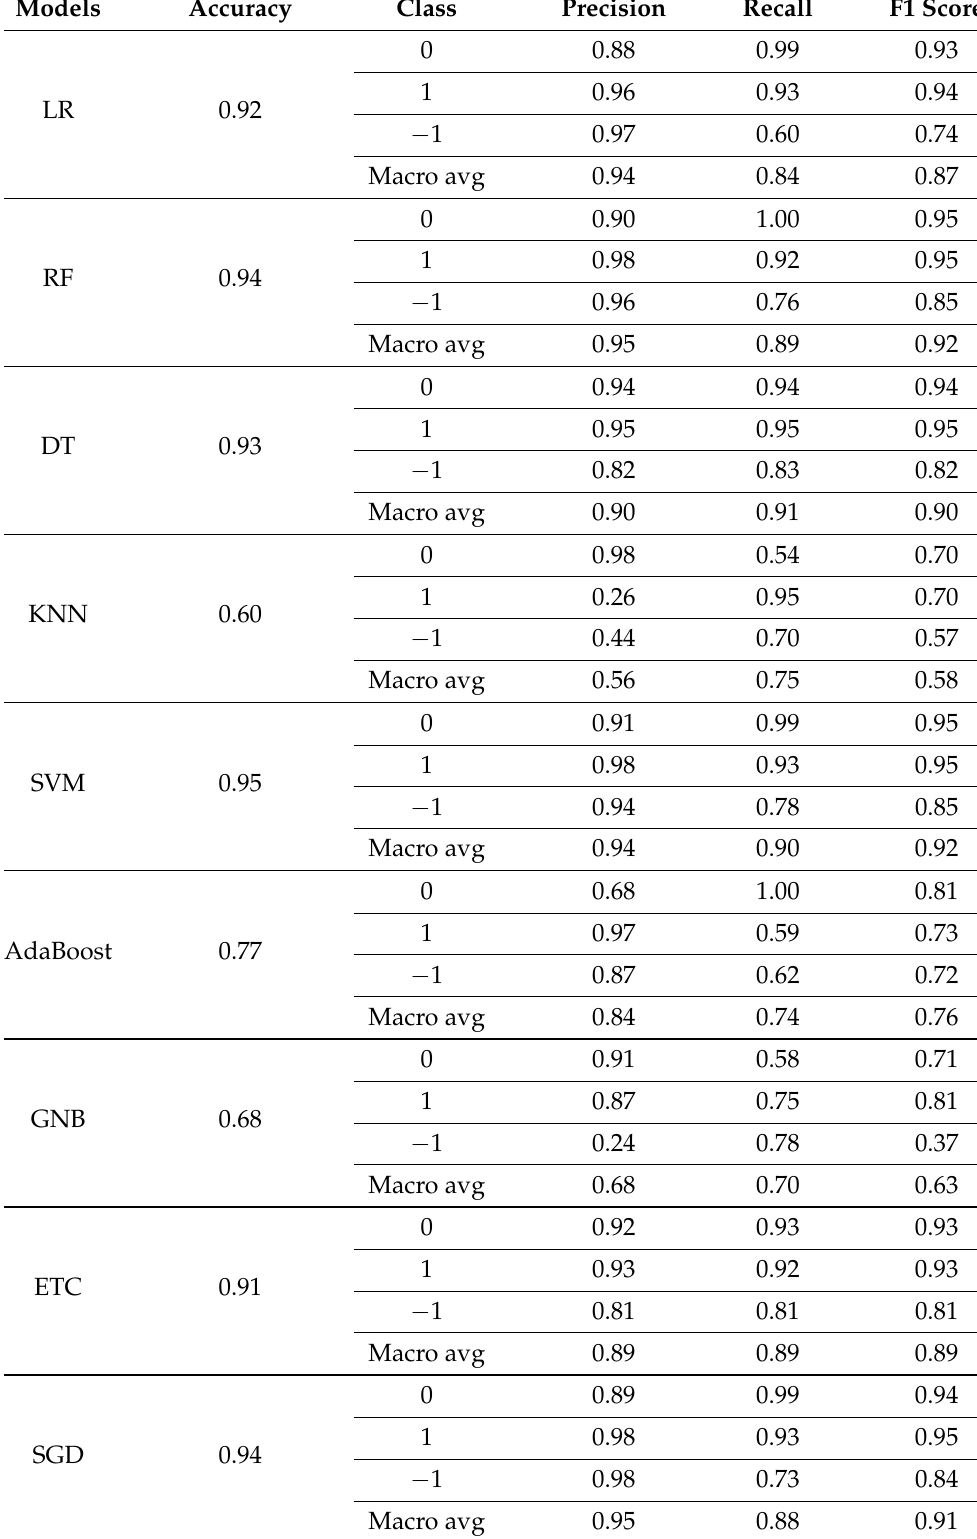
Table 13. Results using TF-IDF features and the SMOTE